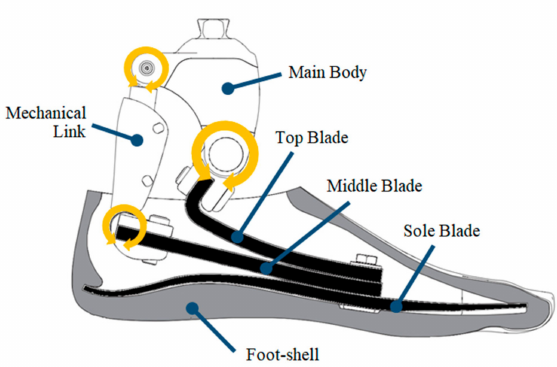
Figure 1. Schematic of the prosthetic foot (Pro-Flex ® [8]), yellow circular arrows showing rotational degrees of freedom in joints, carbon fiber leaf springs colored